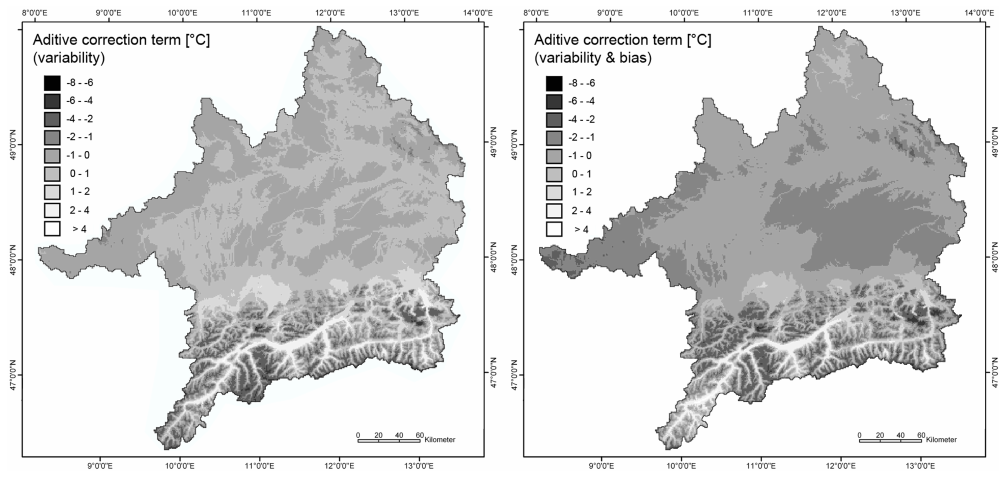
Fig. 4. Downscaling function for the correction for subgrid-scale variability (vari, 1 × 1km) in MM5-simulated temperature (45 × 45km) for January (left) and function for a combined correction for subgrid-scale variability and bias (vari&bias) in MM5-simulated temperature (ERA40 forcings) for January (right) as derived from meteorological observations and simulations for the period 1971–2000.